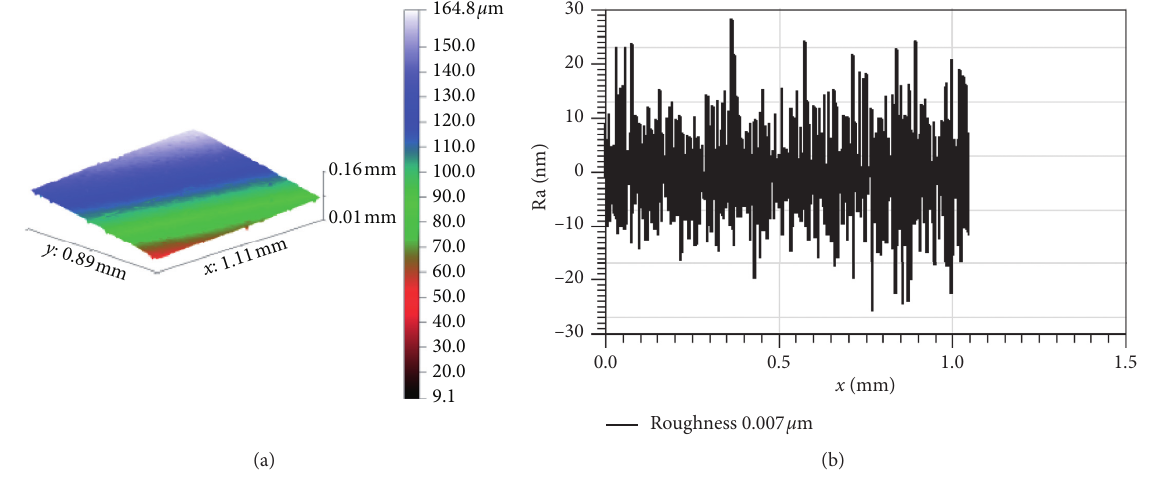
Figure 9: 3D surface profilometer analysis of the polished sample